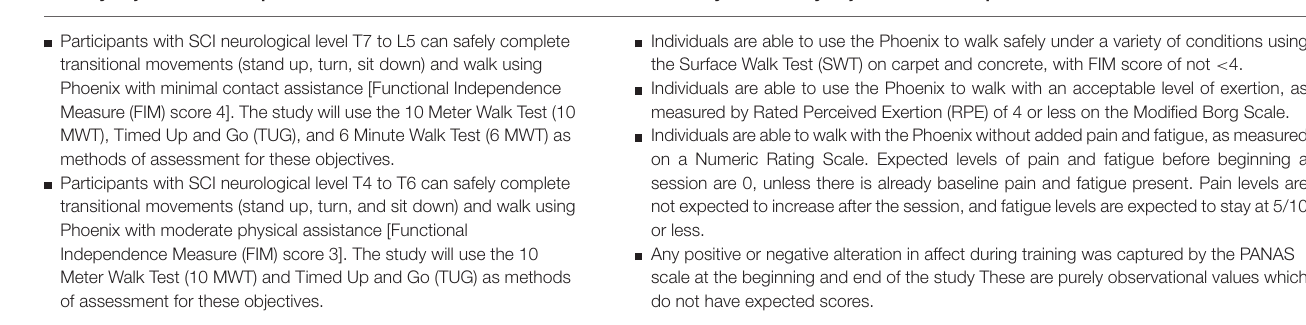
TABLE 1 | Study objectives and endpoints.